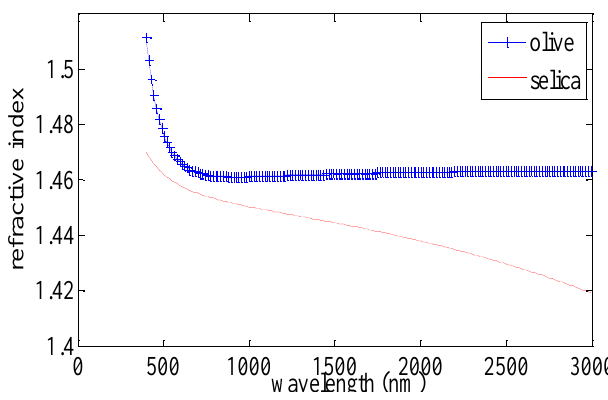
Figure 1. Refractive index versus wavelengths (nm) for olive oil and silica